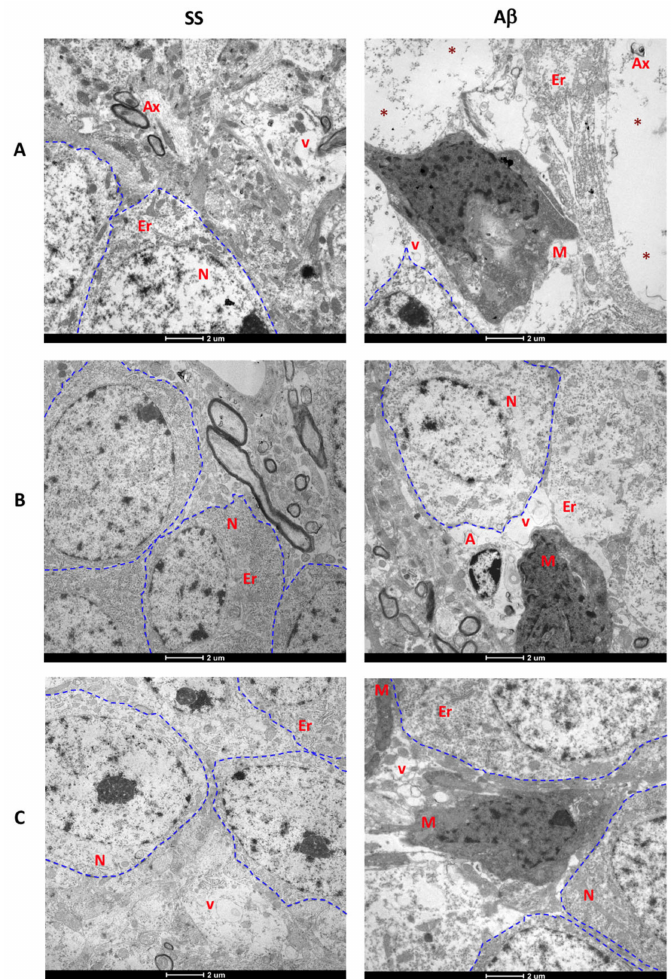
Figure 6. Ultrastructural analysis in chronic days. Transmission electron micrographs (Scale bar: 2 µ m) of ( A ) 7 d, ( B ) 15 d, and ( C ) 30 d are shown. Blue dashed lines identify at least one neuron (N) in each image. In general, A β oligomers induce microglial (M) activation, disruption of cytoplasm and endoplasmic reticulum (ER) in rats sacrificed at 7, 15, and 30 days after injection. At day 7, oligomers promote an increased number of vacuoles (v) in the neuropil and neuronal loss spaces (red asterisks). These spaces are less evident in A β O rats sacrificed at day 15, but swollen astrocytes (A) and vacuolated microglial cells were found. At day 30 some of these cells were still present, but neuron loss, cytoplasm disruption, and alterations in endoplasmic reticulum were less